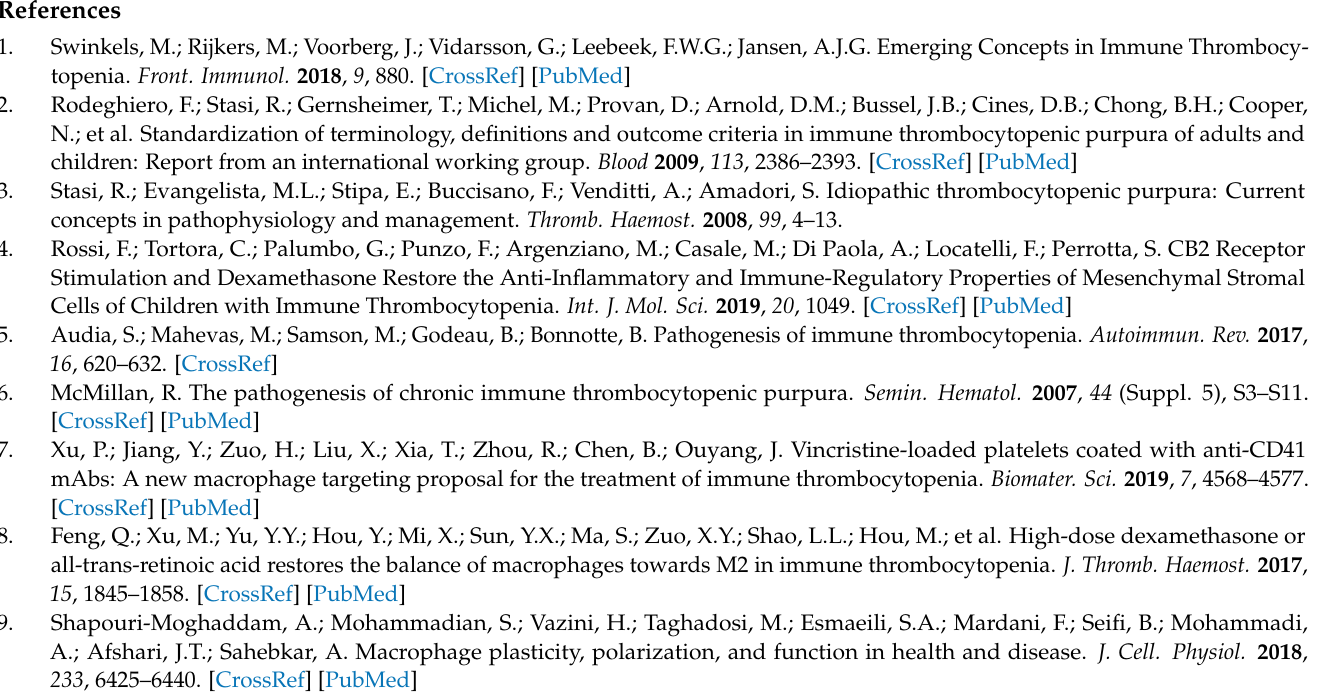
Figure A1. Viability Assay on ITP macrophages treated with different concentration of Eltrombopag. The viability of ITP macrophages was estimated by a cytofluorimetric assay after treatment with Eltrombopag (2, 6, 10, 20, 50 µ M). The histogram shows results as cell number × 10 6 and as mean ± SD of independent experiments on three different patients. * indicates p ≤ 0.05 compared to NT.